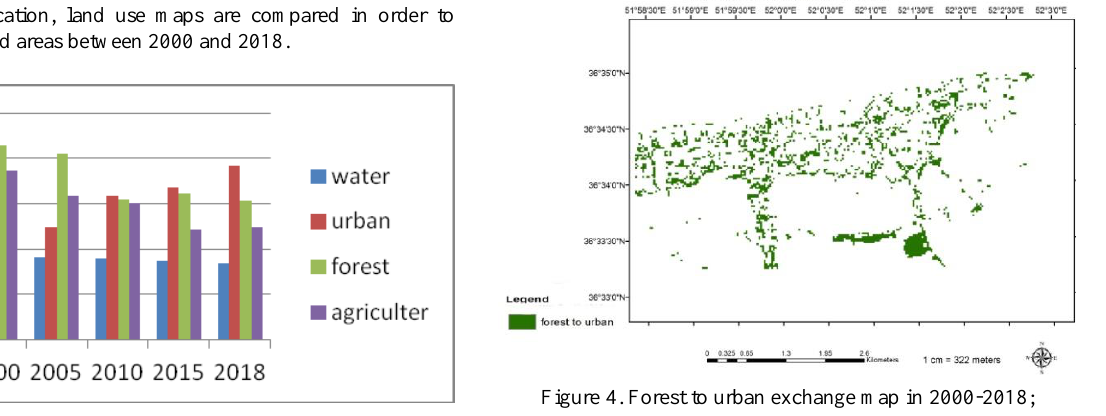
Figure 3. Bar graph of Land use area from 2000 to 2018; urban area has increased and forest area has decreased in time series.